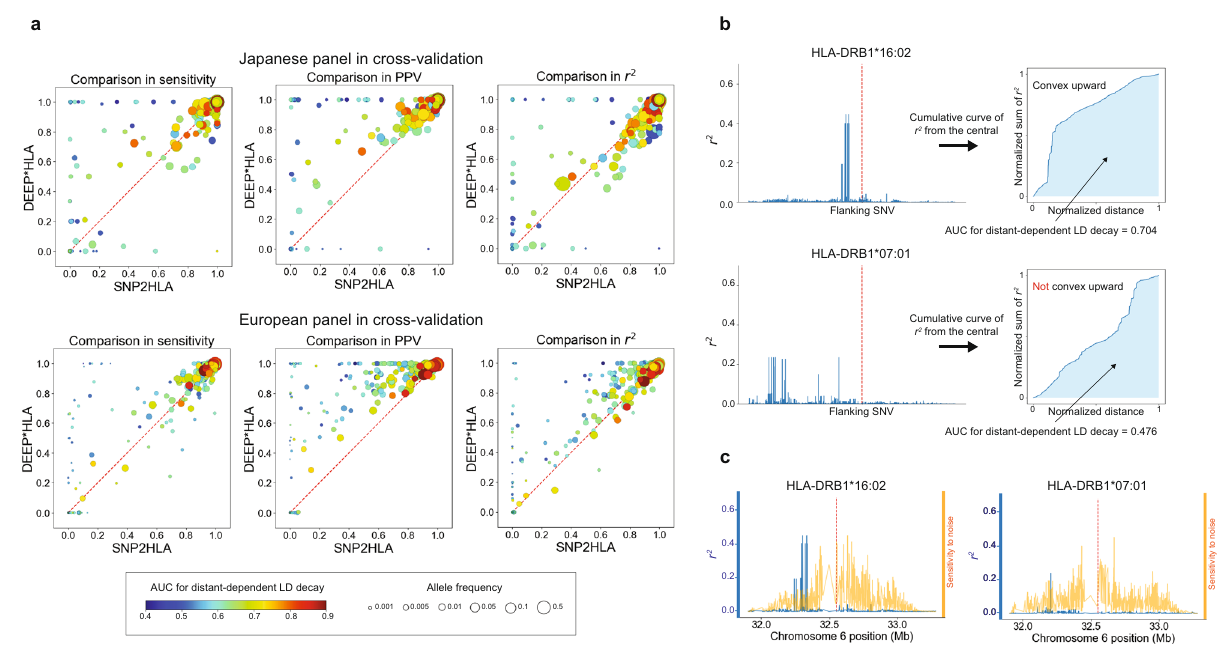
Fig. 4 Comparison between DEEP*HLA and SNP2HLA displayed with allele frequencies and AUC for distance-dependent LD decay. a Comparisons of imputation accuracy between DEEP*HLA and SNP2HLA for 4-digit allele imputation for cross-validation with the Japanese panel (upper) and T1DGC panels (lower). Each dot corresponds to one allele, displayed with allele frequencies (size) and AUC for distance-dependent LD decay (color). The size and color scales are provided in the bottom of the fi gure. The AUC was calculated based on bilateral 1000 SNVs. Comparisons in concordance rate are not shown because they were almost the same as those in sensitivity. The performance of SNP2HLA was limited when imputing the alleles with low-frequency and low AUC; DEEP*HLA was relatively accurate even for the less frequent alleles regardless of AUC. b Example illustrations of AUC for distance- dependent LD decay. The left fi gures illustrate r 2 of LD between an HLA allele (red dash line in the central) and fl anking SNVs. HLA-DRB1*16:02 has strong LD in close positions and weaker LD in the distant positions. The cumulative curve of r 2 of bilateral SNVs becomes convex upward; and the AUC increases. In contrast, HLA-DRB1*07:01 has moderate LD in distant or sparse positions, the curve does not become convex upward, and the AUC becomes smaller. c Comparison between r 2 (blue line) and sensitivity maps of DEEP*HLA (orange line) for example alleles (red dash line in the center). The sensitivities are normalized for visibility. In both examples, DEEP*HLA reacted to noise across an extensive area regardless of LD. PPV positive predictive value, AUC area under the curve, LD linkage